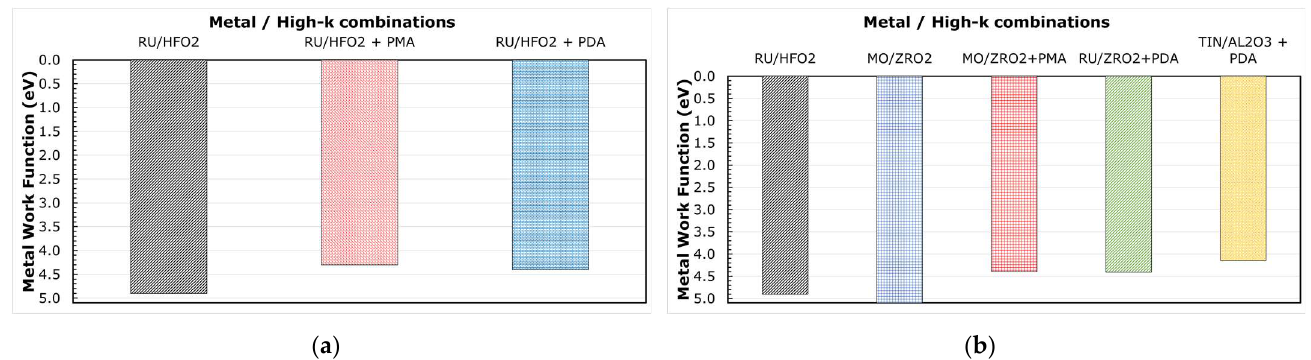
Figure 12. WF extracted for multiple metal and high-k combinations after different annealing conditions. ( a ) Ru with HfO 2 ; ( b ) Ru, Mo with ZrO 2 , and TiN with Al 2 O 3 .